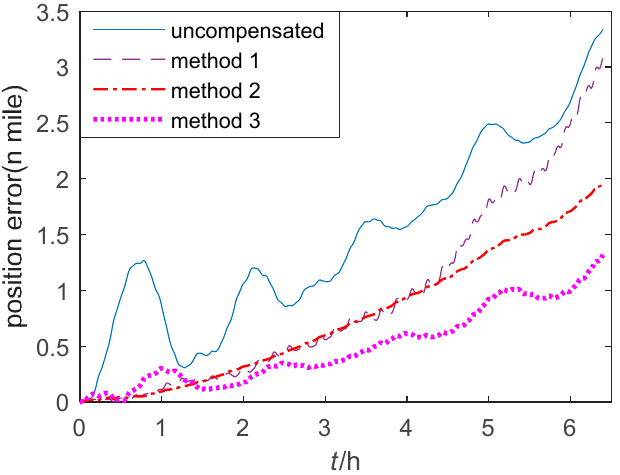
Figure 9. The position error of single-axis RINS in the thermal verification experiment.